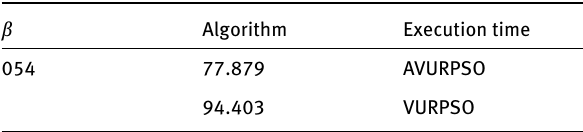
Table 3: A comparison between AVURPSO and VURPSO on execution time in Example 1.